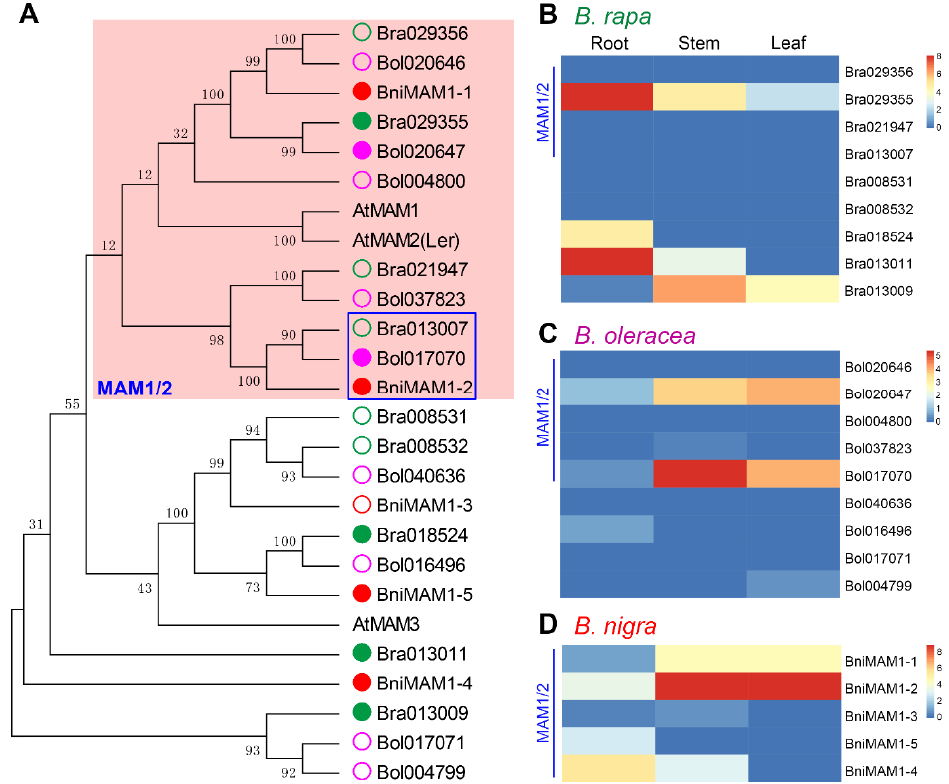
Figure 6. The phylogenetic tree and heatmap of MAM genes in Brassica rapa , Brassica oleracea , Brassica nigra , and Arabidopsis thaliana . ( A ) The phylogenetic tree of MAM genes. The MAM genes identified from Brassica rapa , Brassica oleracea , and Brassica nigra are indicated by green, purple, and red hollow circles or solid discs. The silenced genes are represented by a hollow circle, expressed functional genes are indicated by a solid disc. The heatmap of MAM genes in Brassica rapa ( B ), Brassica oleracea ( C ), and Brassica nigra ( D ). The expression data of B. rapa and B. oleracea were obtained from ref [48,49].